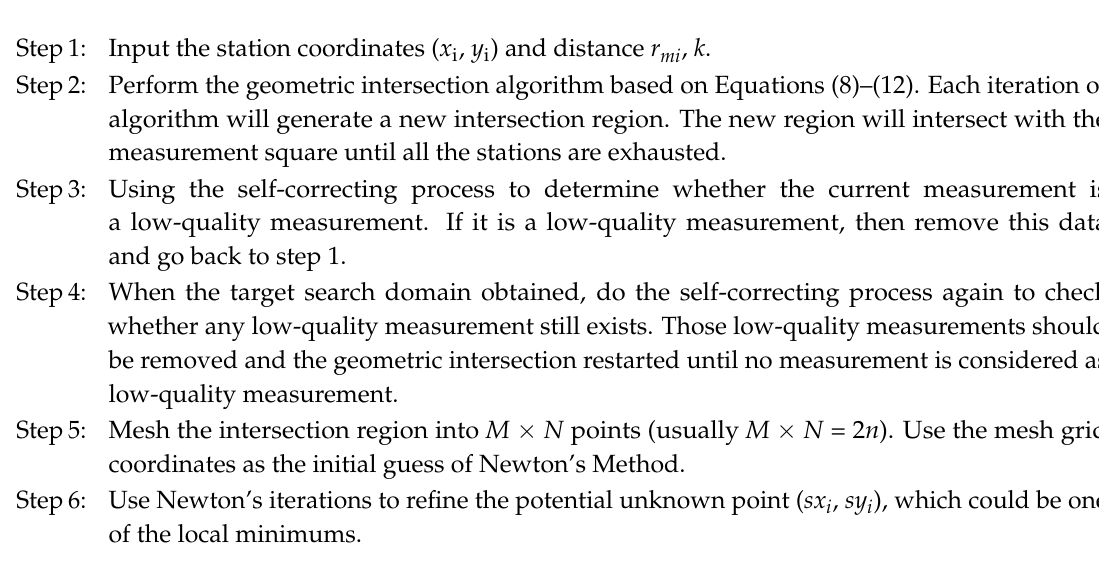
Figure 5. Flowchart of the computational algorithm.